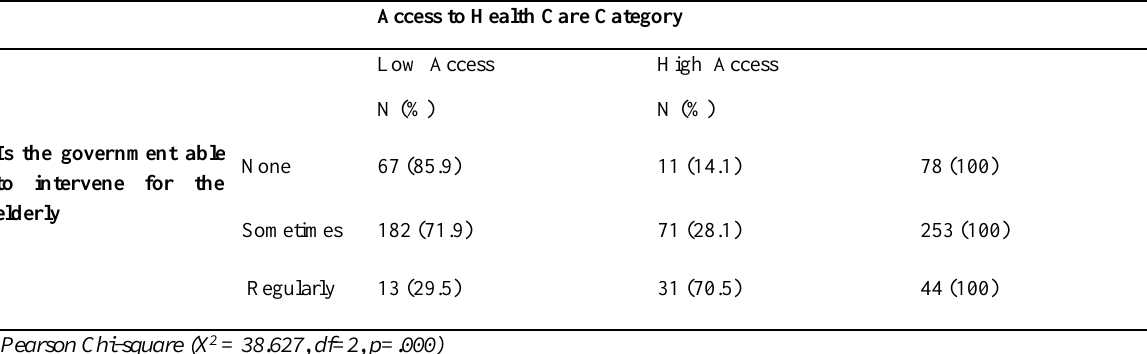
Table 7: Cross-Tabulation of Government Intervention and Access to Health Care